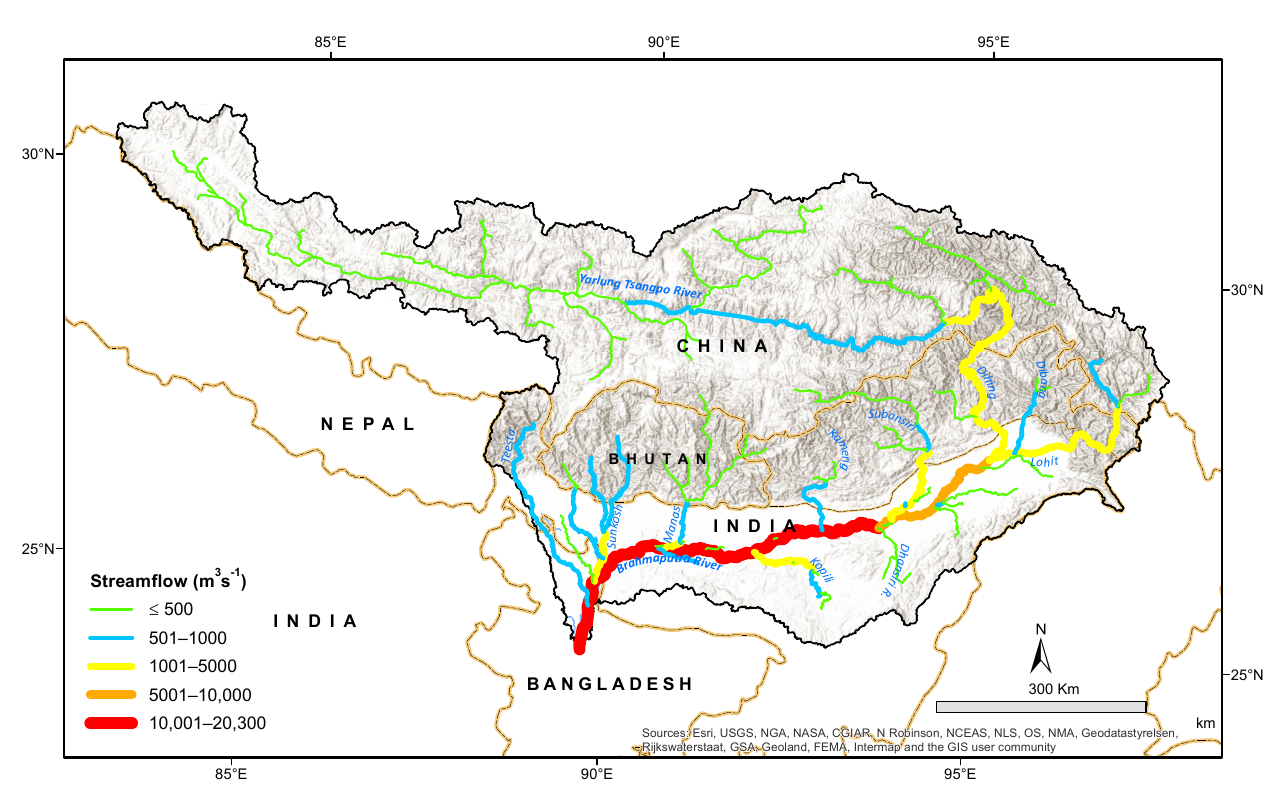
Figure 8. Average annual streamflow contribution by different tributaries in the Brahmaputra basin in 1998–2007.